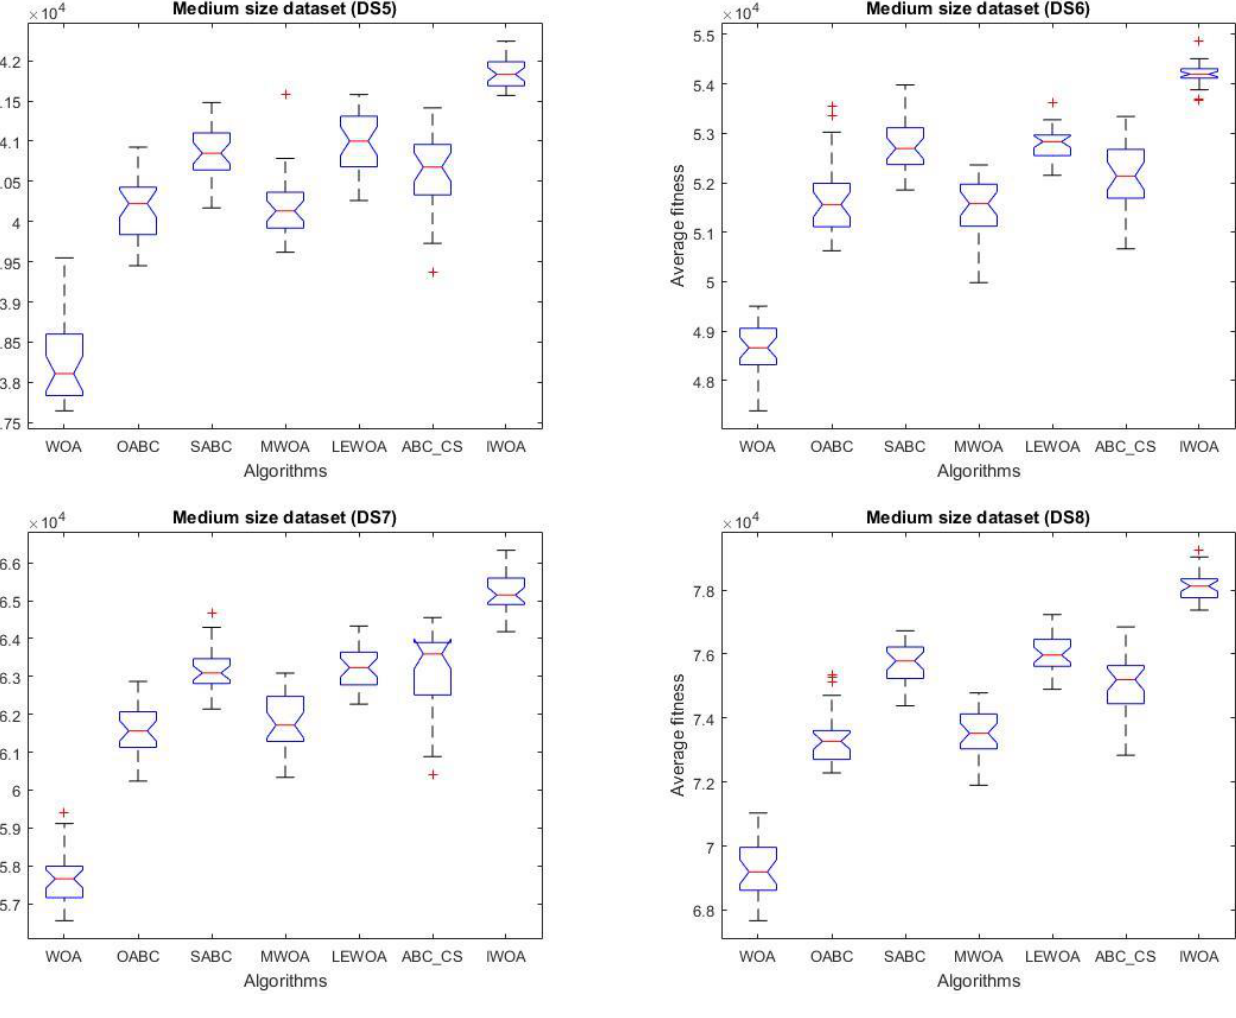
Figure 3. Boxplots for the average fitness value obtained using the compared algorithms for the medium size dataset.